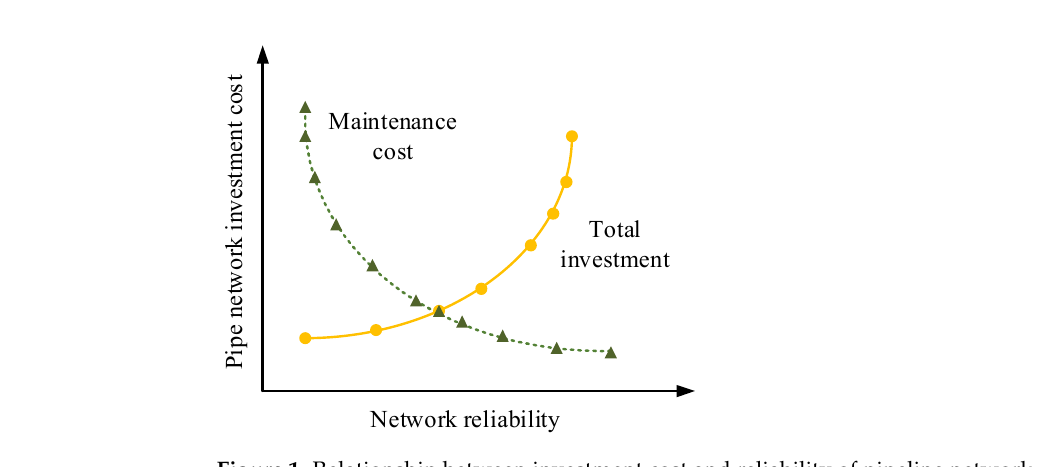
Figure 1. Relationship between investment cost and reliability of pipeline network.